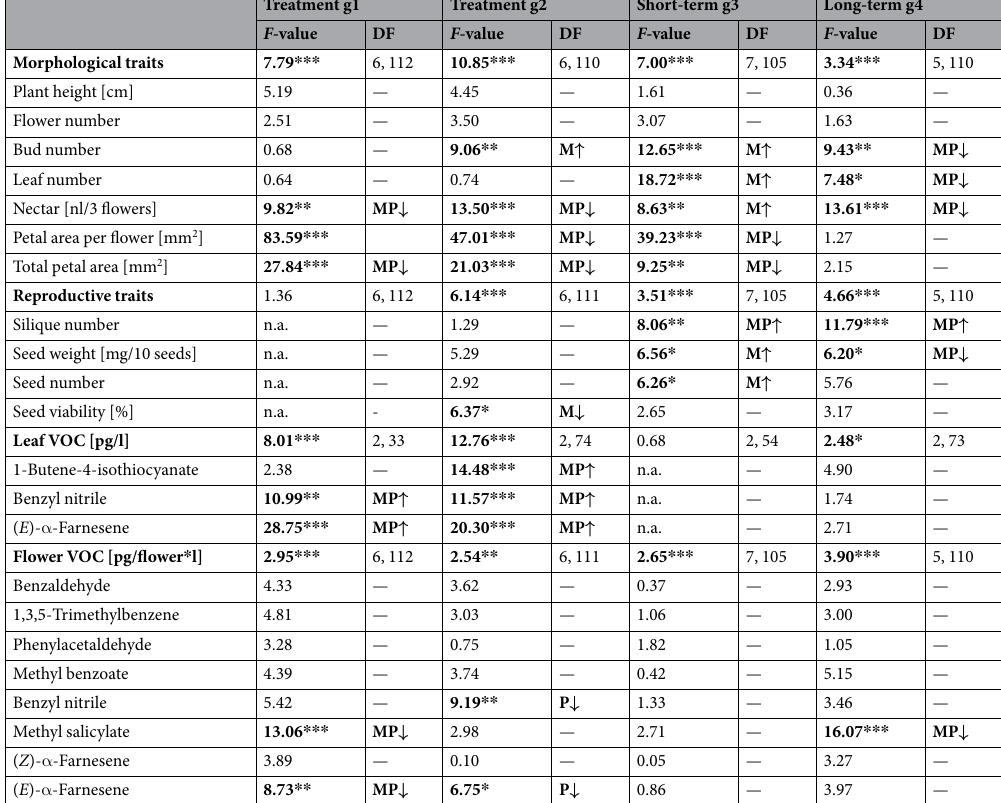
Table 1. Summarised MANOVA and two-way ANOVA analyses of trait changes upon herbivory. Significance levels: * P < 0.05; ** P < 0.01; *** P < 0.001. “DF”: degrees of freedom within and between groups per generation and trait type. “M”: effect on M. brassicae group, “P”: effect on P. brassicae group. Arrow up ( ↑ ): increase in trait value, arrow down ( ↓ ): decrease in trait value, minus ( − ): no change in trait value, “n.a.”: no ANOVA calculated due to non-significant MANOVA result ( P ≥